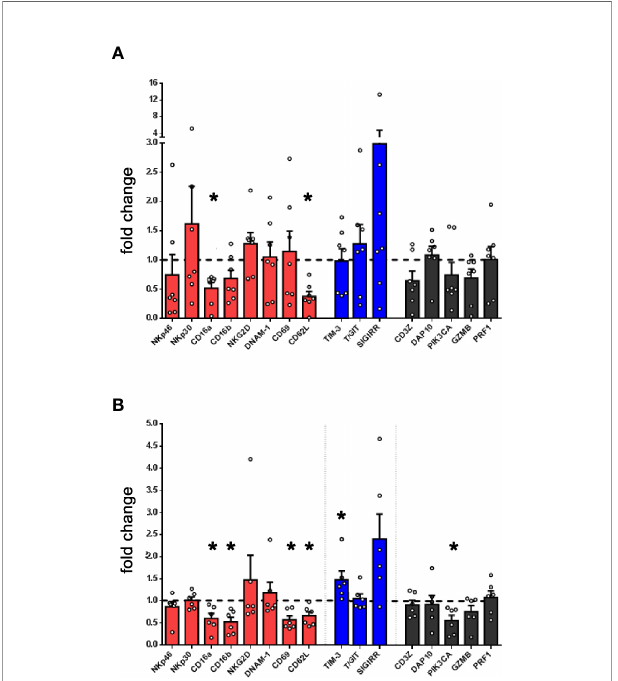
FIGURE 3 | Lung tumor NK cells display an impairment of their activation status and inversely correlate with PMN-MDSC. (A) The expression of a panel of selected genes associated to NK cell function was evaluated by PCR array in PB-NK cells derived from lung cancer patients (n = 7). Values are expressed as fold change with respect to NK cells from HD (n = 5). Bars represent SEM. (B) The expression of genes associated to NK cell function was evaluated in short-term IL-2 activated NK cells upon co-culture with lung cancer PMN-MDSC. Values are expressed as fold change with respect to NK cells cultured with IL-2 only, used as control (n=6). *p ≤